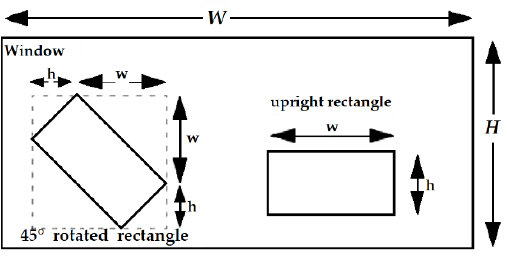
Figure 7. The examples of upright and 45° rotated rectangles.